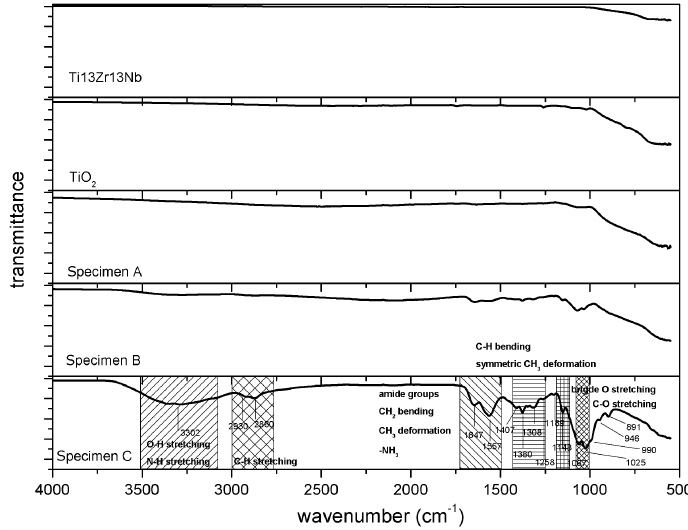
Figure 8. Fourier-transform infrared (FTIR) spectra of the Ti13Zr13Nb substrate and the substrate with the TiO 2 nanotube layers: Specimen A, Specimen B, and Specimen C.